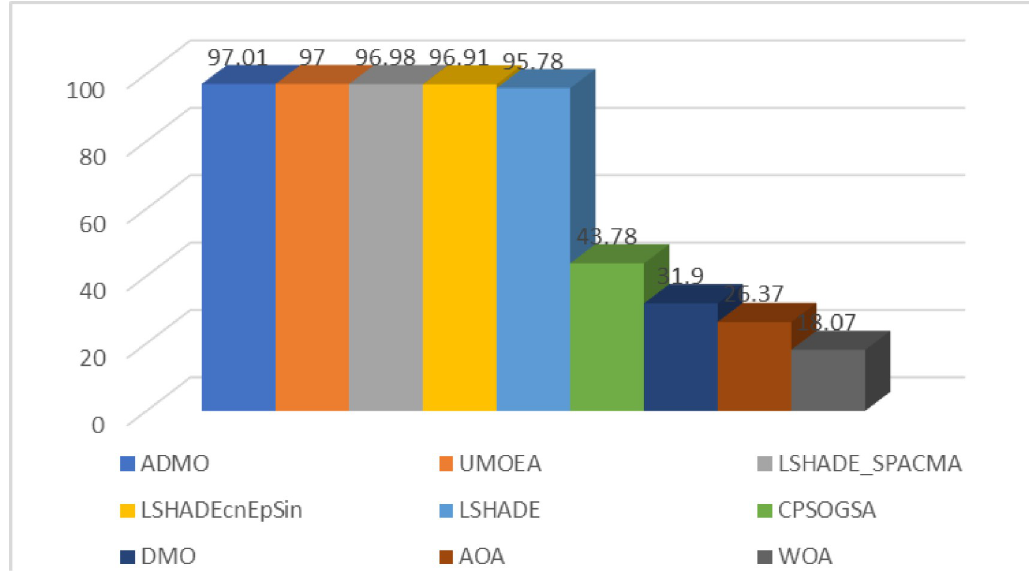
Fig 4. Graphical representation of the algorithm’s performance score.